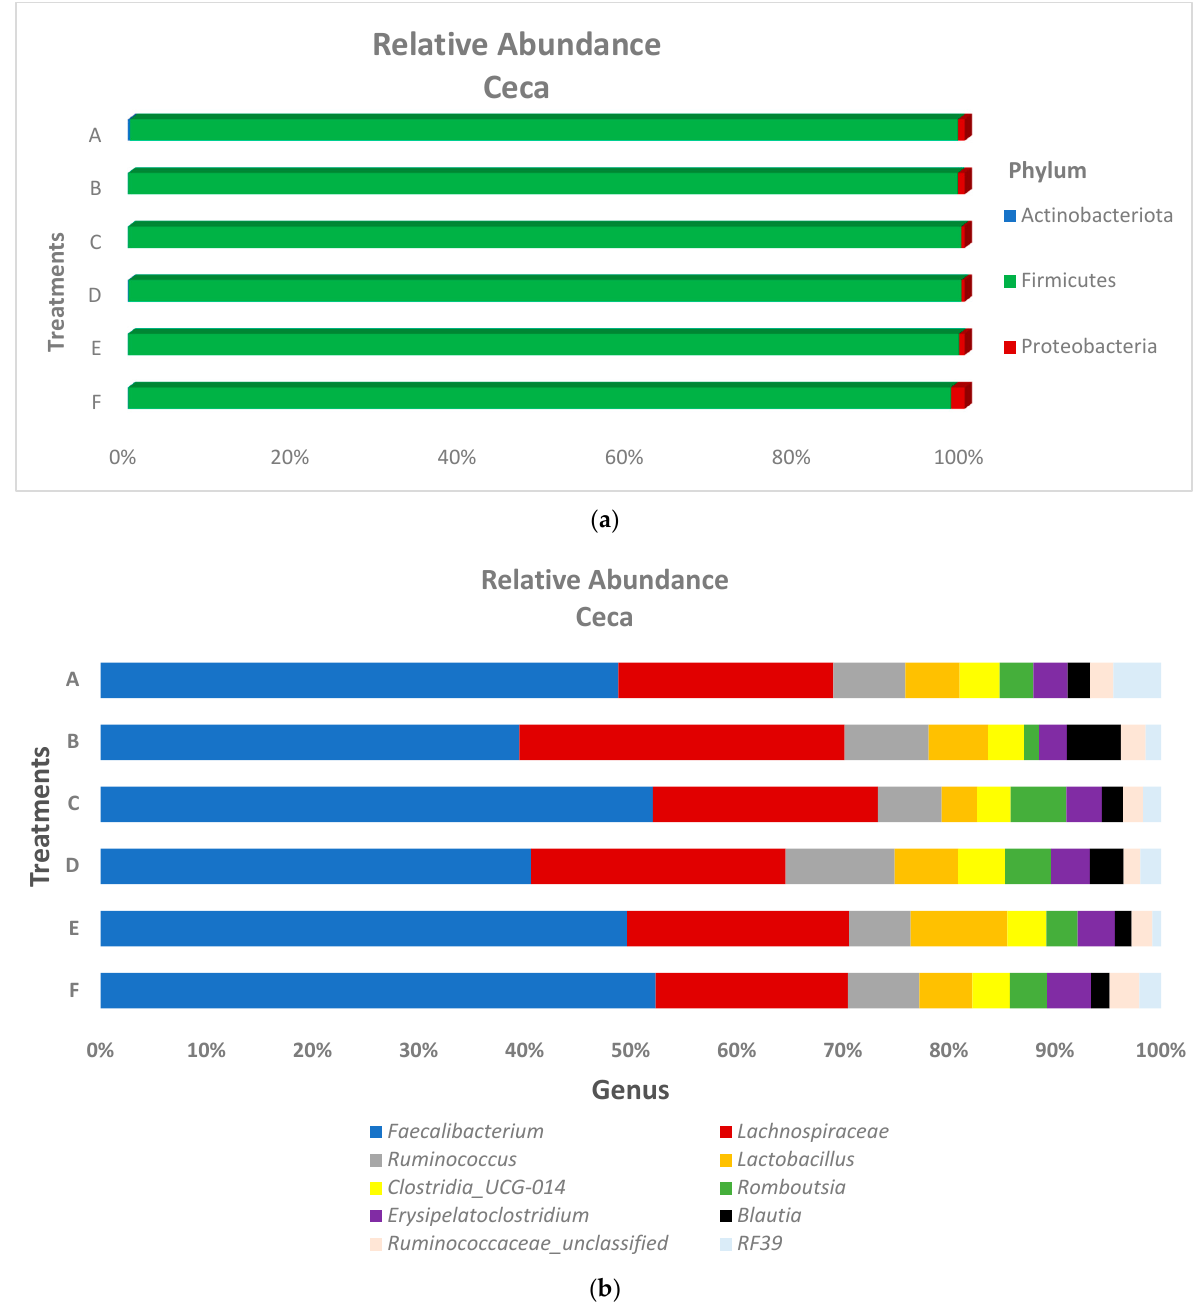
Figure 4. Ceca microbiota bacteria composition at the ( a ) phylum and ( b ) genus levels of broiler chickens subjected to different treatments groups. Treatments include (A) negative control treatment—chicks fed a basal corn-soybean meal-wheat-based diet; (B) in-feed antibiotics—chicks fed NC + 0.05% bacitracin methylene disalicylate; (C) in-water essential oil—chicks supplied the essen- tial oil via the water route at the recommended dosage of 250 mL/1000 L of drinking water; (D) in